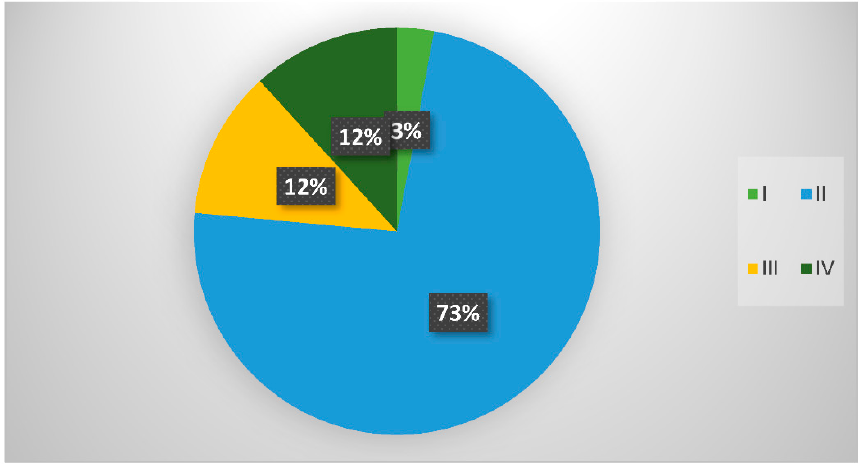
Figure 9. The percentage of different decision-making models used in the studied projects.